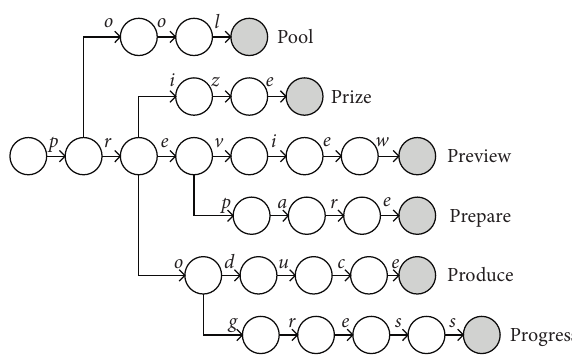
Figure 4: Sample of